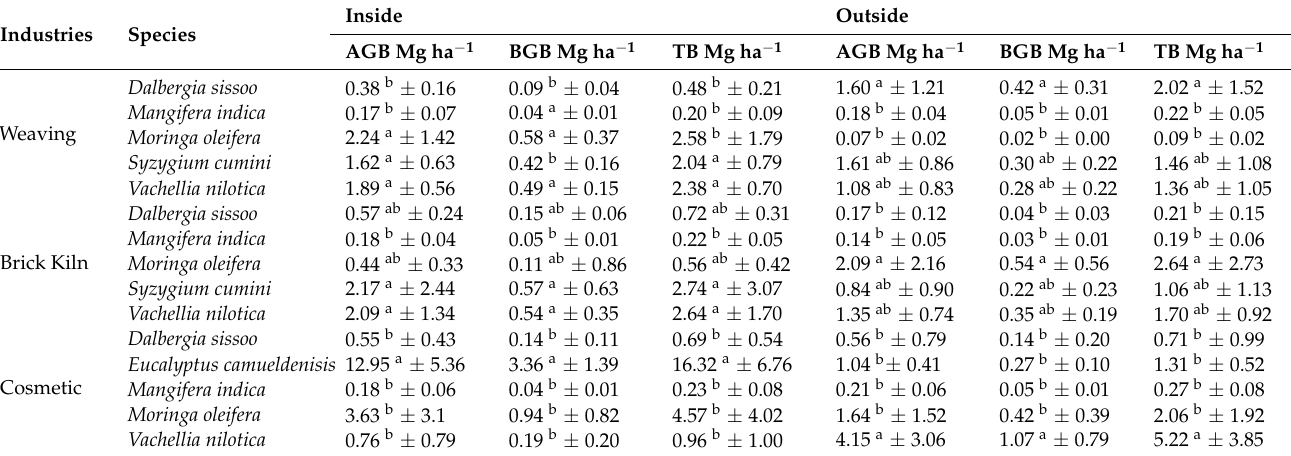
Table 4. Biomass of different tree species present inside and outside the different